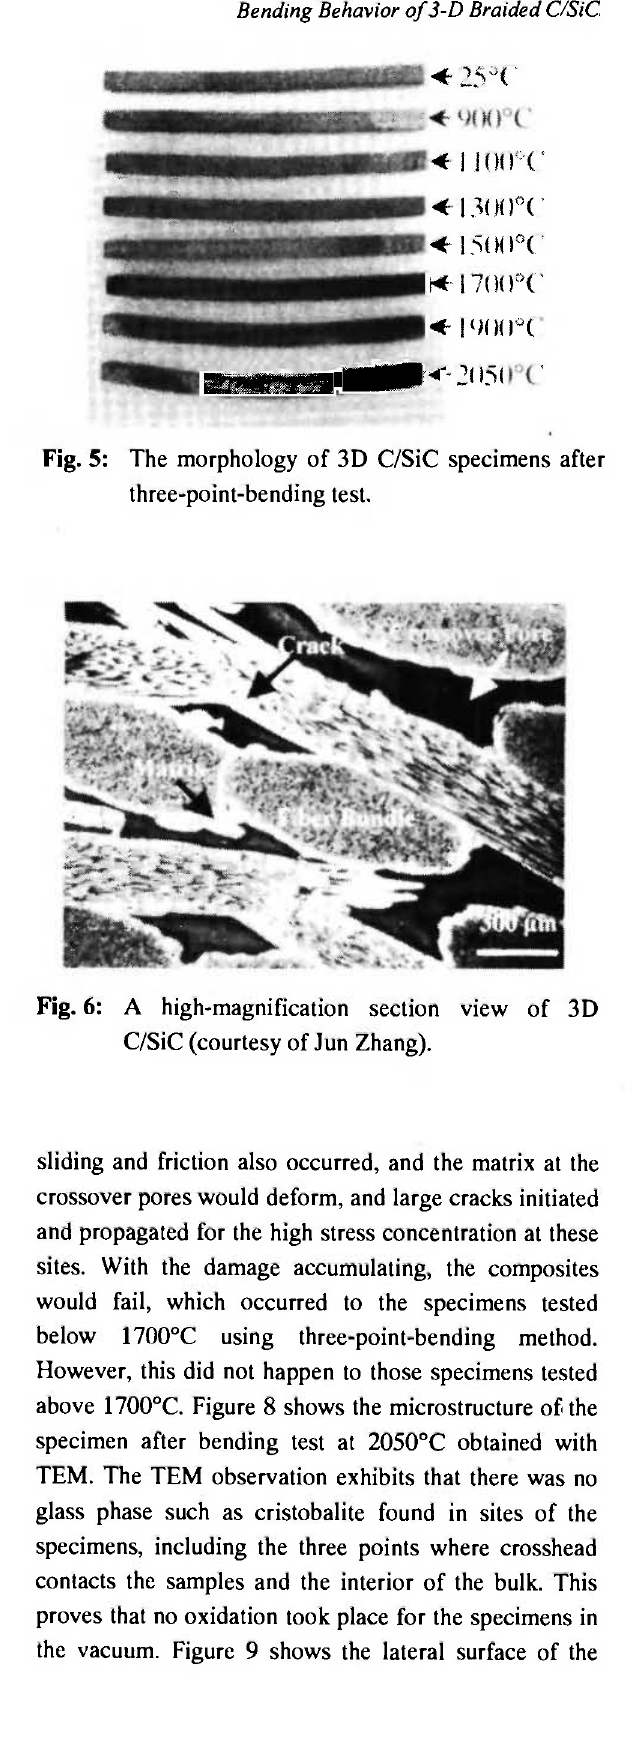
Fig. 5: The morphology of 3D C/SiC specimens after three-point-bending test.